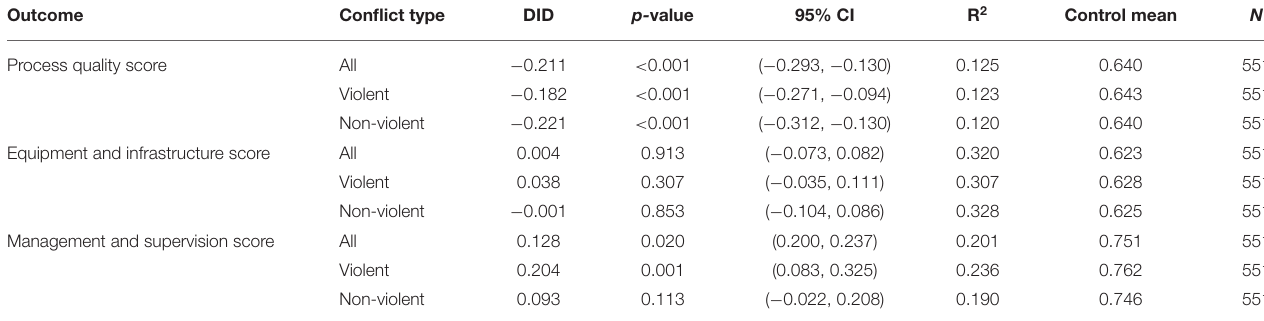
TABLE 12 | Variation in DID estimates with conflict